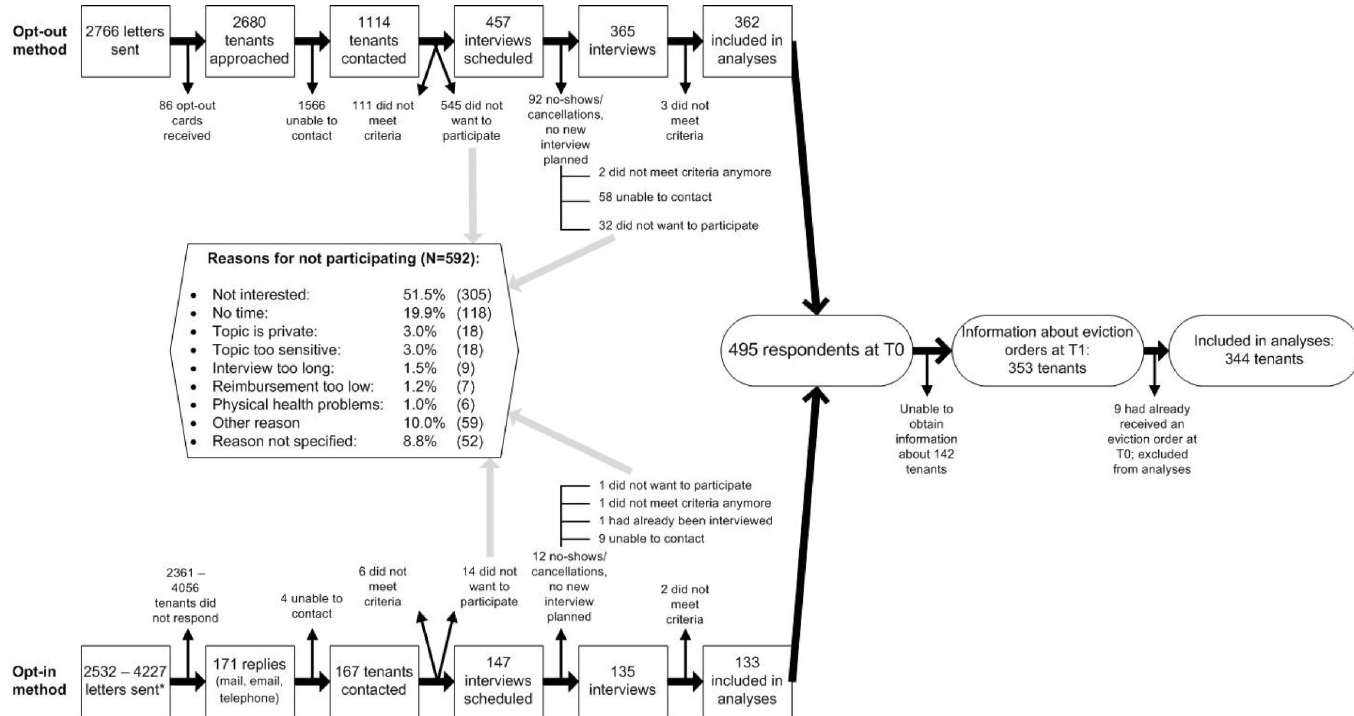
Fig 1. Response and non-response at T0 and T1, using the opt-in and opt-out methods. � Since not all housing associations, municipal institutions and debt counseling agencies kept track of the number of letters they sent, it is unclear exactly how many tenants received opt-in letters or flyers.